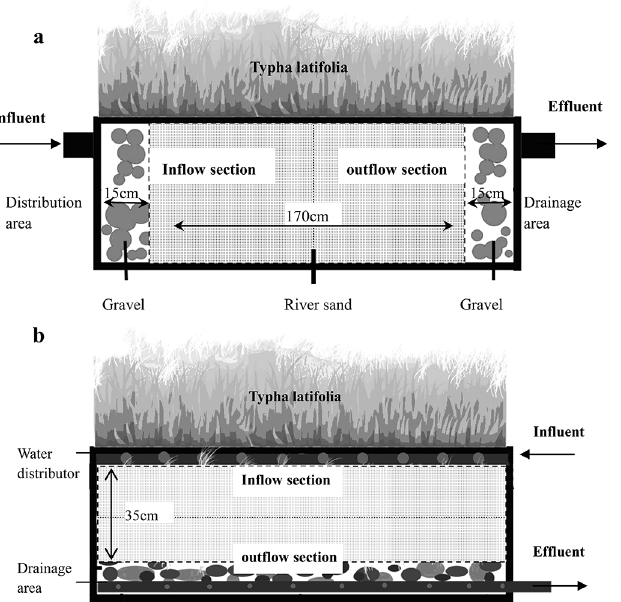
Fig 1. Construction of CWS with horizontal subsurface flow(a) and Vertical subsurface flow(b).